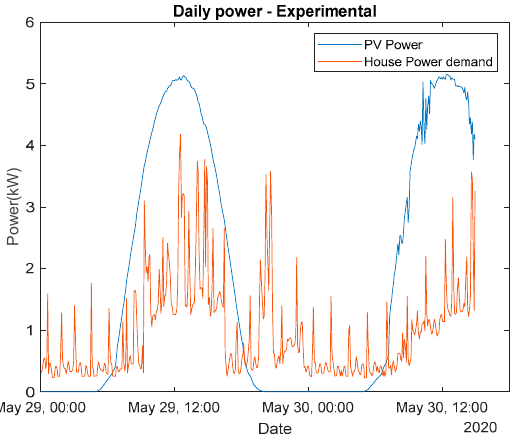
Figure 18. PV power and house power demand (sunny day).